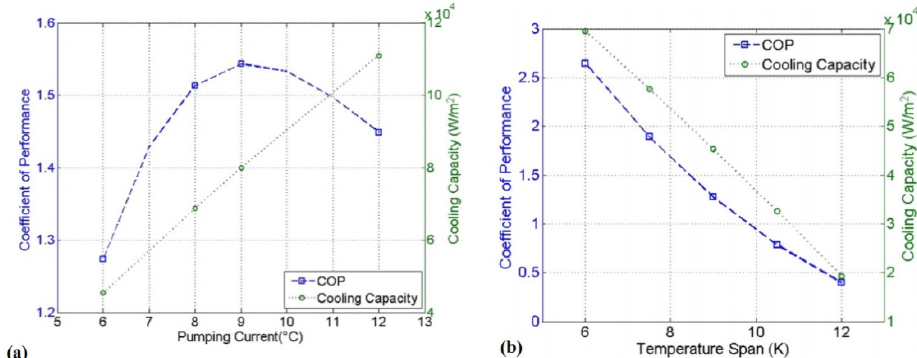
Figure 11. ( a ) Coefficient of performance ( COP ) and cooling capacity vs. pumping current; ( b ) COP and cooling capacity vs. temperature span at 6 °C as electric pumping current applied (reprinted with permission from [65], The American Society of Mechanical Engineers, 2016).